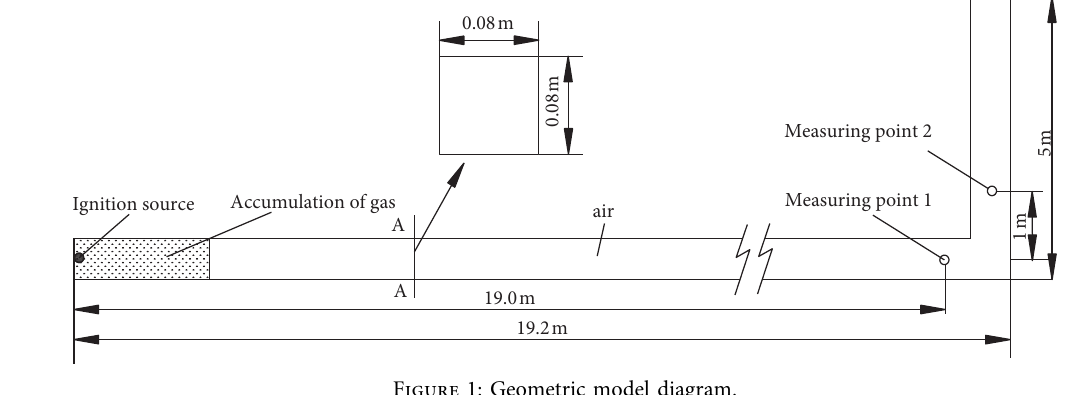
Figure 1: Geometric model